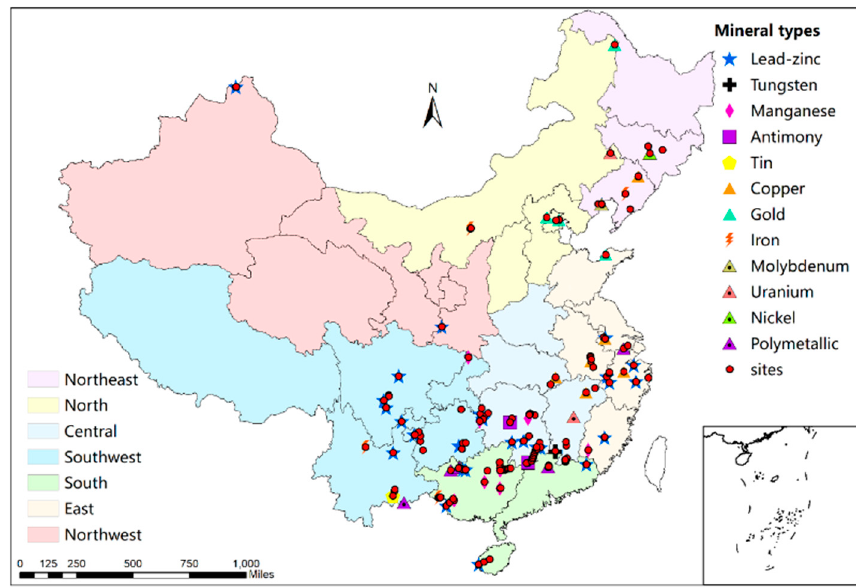
Figure 1. Distributions of sites and different mining areas in China.